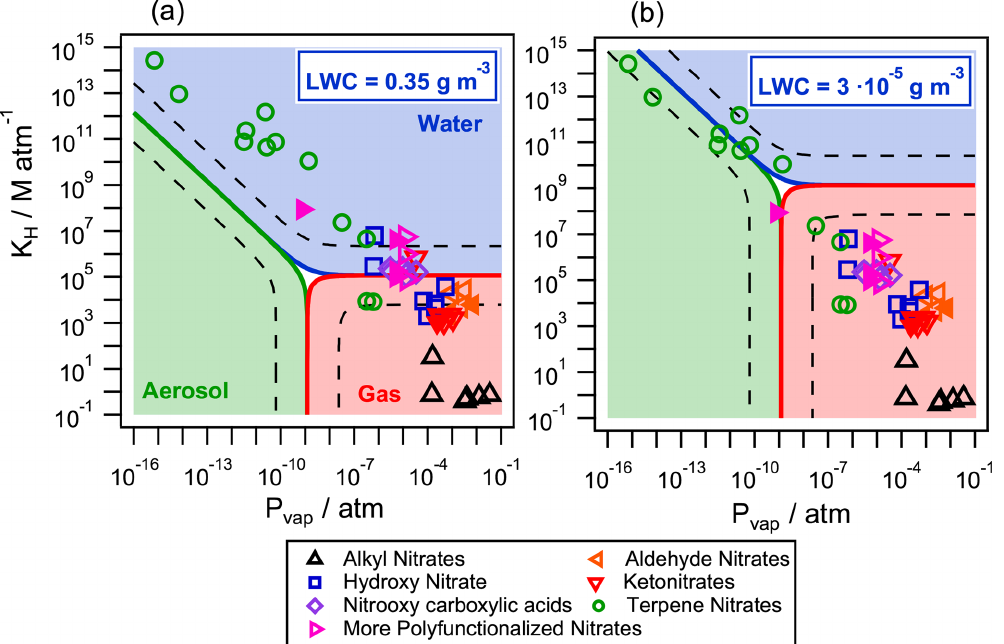
Figure 7. Partition of atmospherically relevant organic nitrates in the aqueous phase (blue), the gas phase (red), and the aerosol phase (green) for two different air parcels with (a) LWC = 0.35gm − 3 (cloud/fog conditions) and (b) LWC = 3 . 5 × 10 − 5 gm − 3 (wet aerosol conditions). The temperature was set to 298 K and the aerosol mass concentration to C aer = 1 × 10 − 5 gm − 3 with a M aer = 200gmol − 1 . The dashed lines represent the limits where the concentration of one compound exceeds 95% in each phase. Filled markers represent organic nitrates derived from